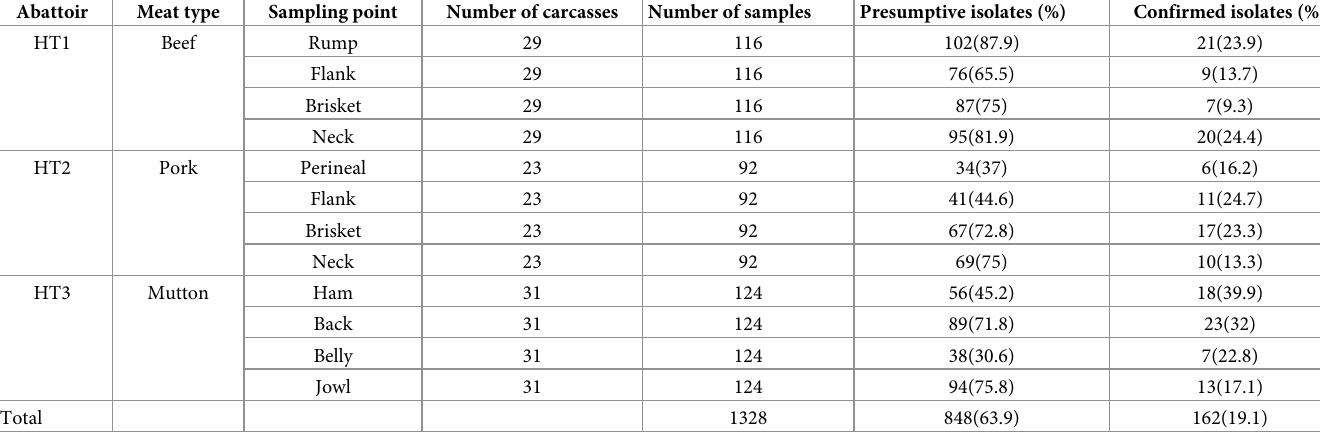
Table 1. Percentage of confirmed isolates from beef (n = 29), pork (n = 23), and mutton (n = 31) in the formal meat sector. Abattoir